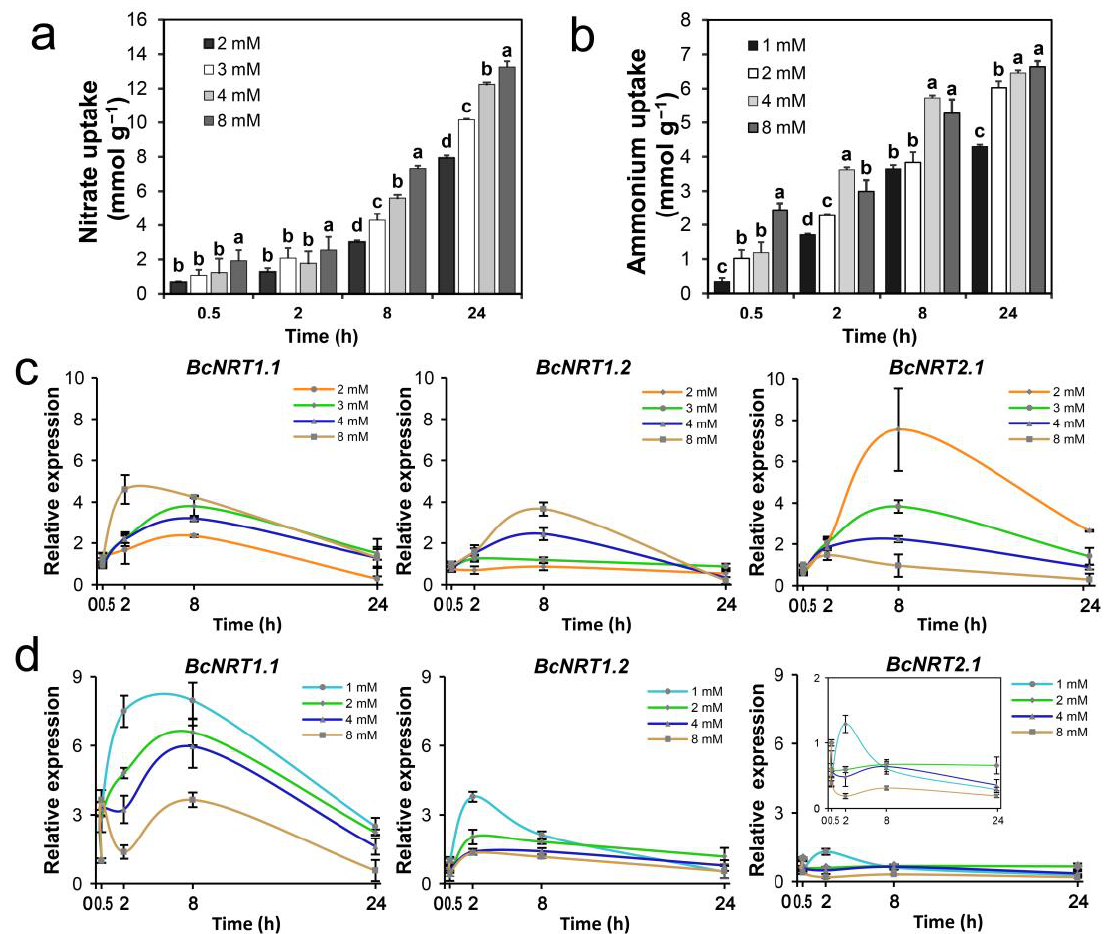
Figure 3. Effects of different N sources on the N absorption characteristics and NRT genes expression of flowering Chinese cabbage. ( a , b ) Effects of different N sources on the N absorption characteristics. ( c , d ) The roots BcNRT genes expression, as affected by different NO 3 − ( c ) and NH 4+ ( d ) concentrations. The housekeeping gene GAPDH was used as an internal reference gene. The data represent the mean ± SE ( n = 3). Different letters in ( a , b ) indicate significant differences at p < 0.05.